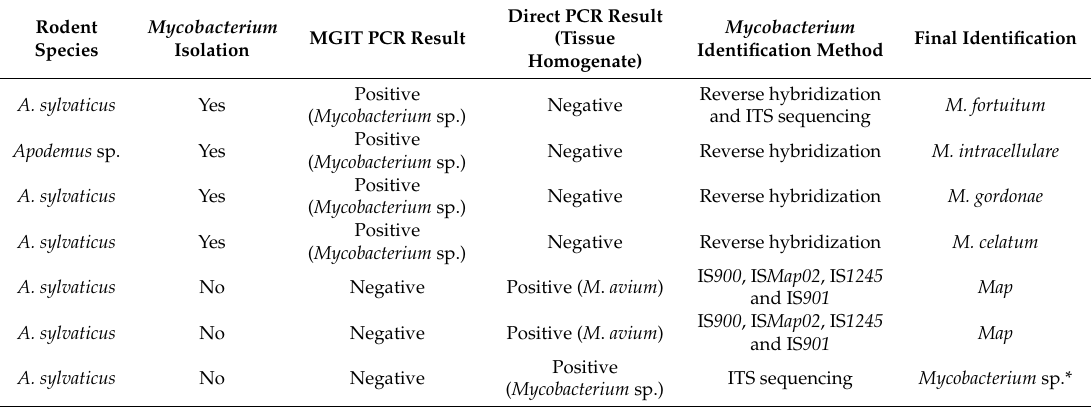
Table 2. Mycobacteria detection and identification in positive small mammal specimens.